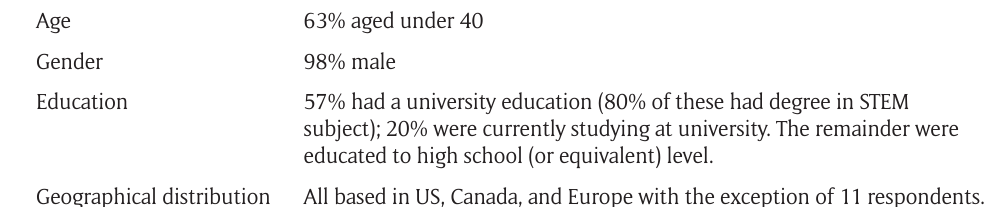
Figure 3: Customised “rig.” The use of neon lighting and purpose-built display cases add to the aesthetic appeal of the machine (image from the EVGA Folding Forum). Table 2: Demographic characteristics of survey group (n =